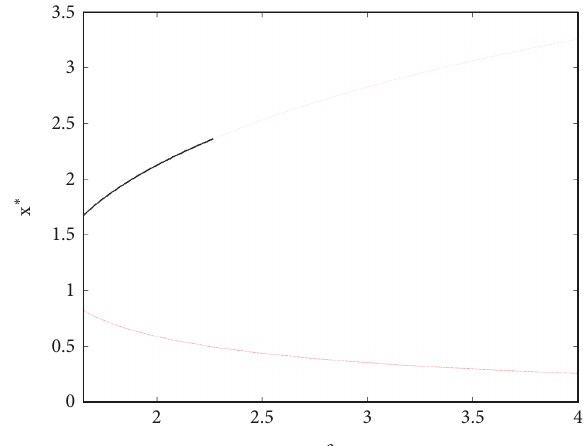
Figure 1: (Color online) Stability diagram of equilibrium points 𝐸 1,2 versus the parameter 𝑎 for 𝑏 = 3 . Solid black lines indicate the stable branches and the dashed red lines the unstable